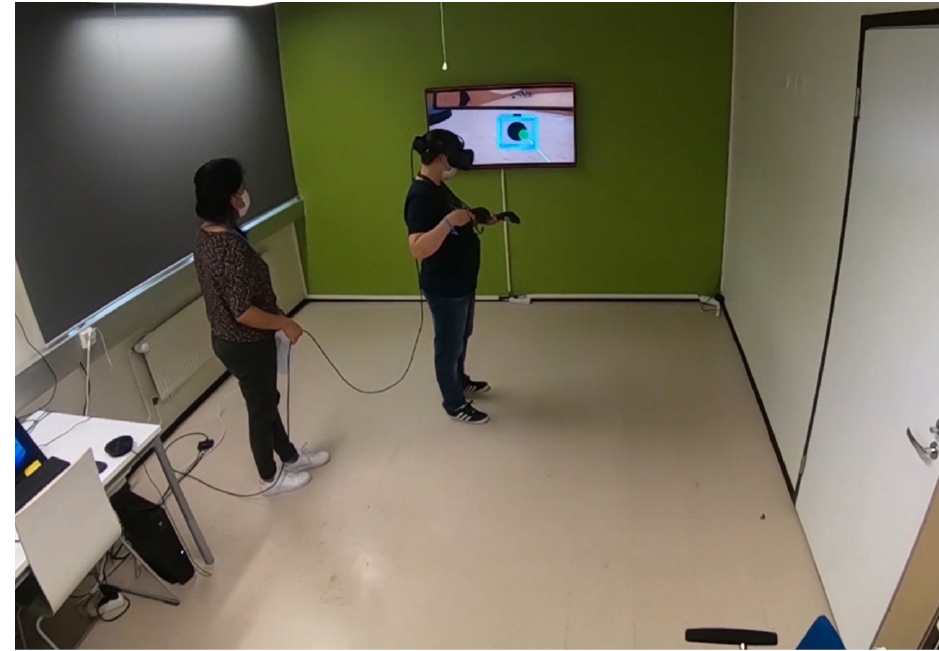
Figure 6. VR session, view from off-line camera during user tests in Case 3.